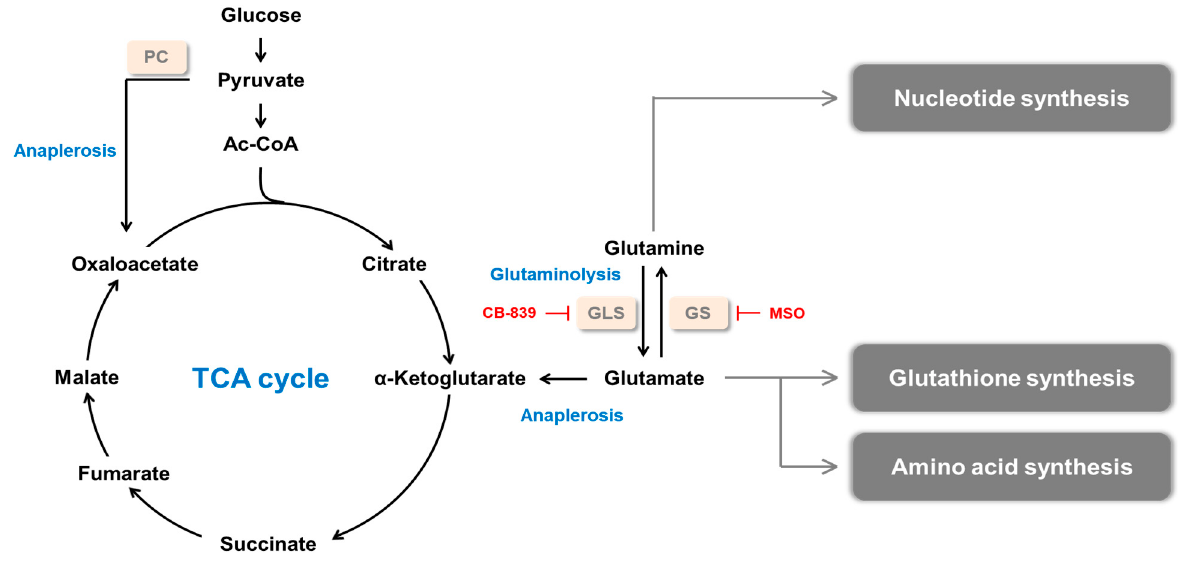
Figure 1. Glutamine metabolism in cancer. Glutamine synthesized by GS contributes to nucleotide synthesis. Glutamine is converted to glutamate by GLS, and glutamate is used for the biosynthesis of glutathione (GSH) and amino acid. α -ketoglutarate ( α -KG) is converted from glutamate and replenishes tricarboxylic acid (TCA) cycle, supporting the synthesis of diverse macromolecules. PC: pyruvate carboxylase, GLS: glutaminase, GS: glutamine synthetase, MSO: methionine sulfoximine.